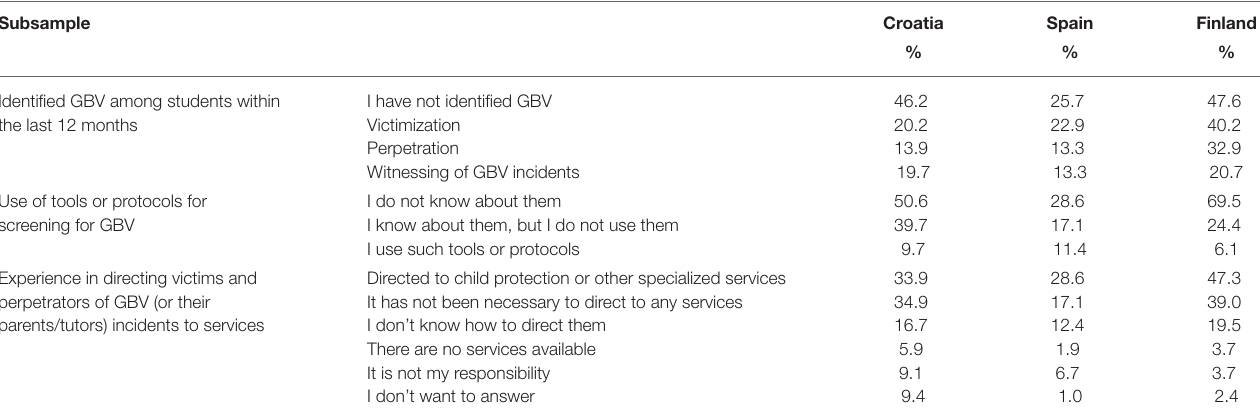
TABLE 4 | Strategies for intervening with cases of SRGBV.